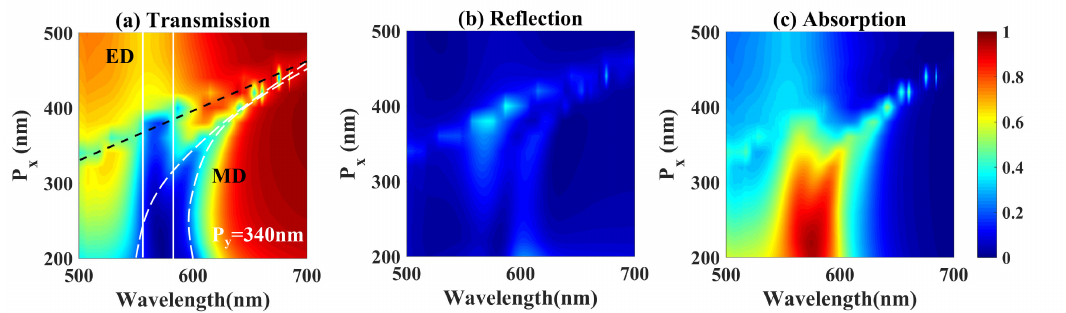
Figure 3. The simulated ( a ) transmission, ( b ) reflection, and ( c ) absorption spectra of the metasurface with different periods P x . P y is fixed at 340